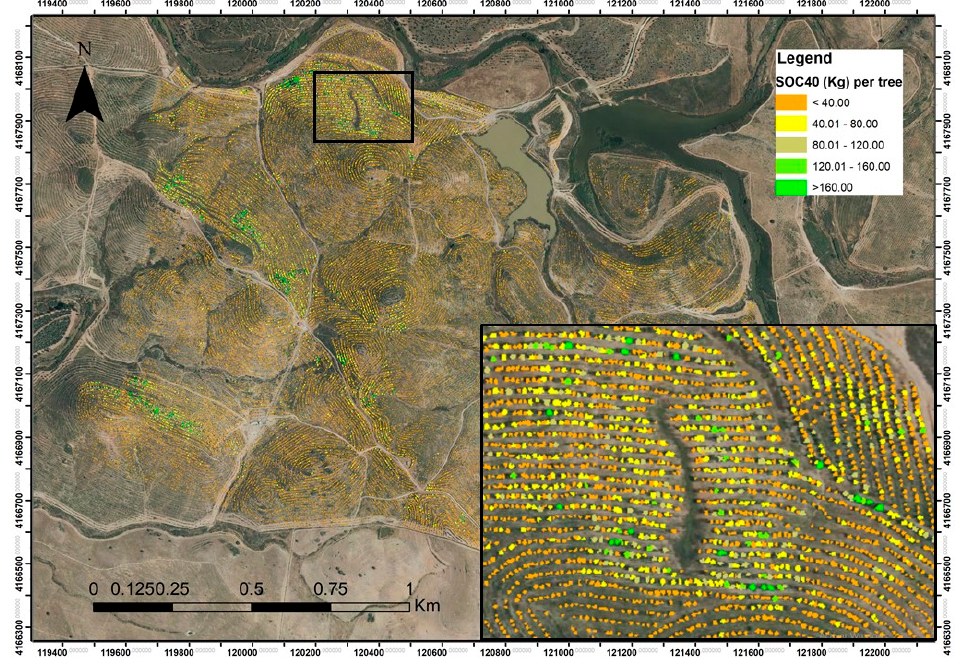
Figure 3. Cartography of soil organic C stocks in the Quercus ilex-Q. suber plantation at Puebla de Guzmán (Huelva, Southwestern Spain).